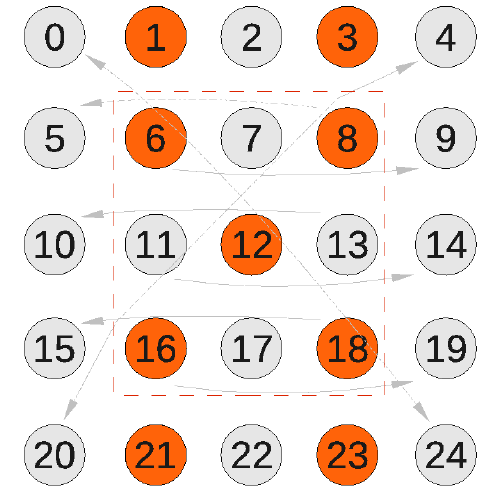
Figure 1. The simulated testbed